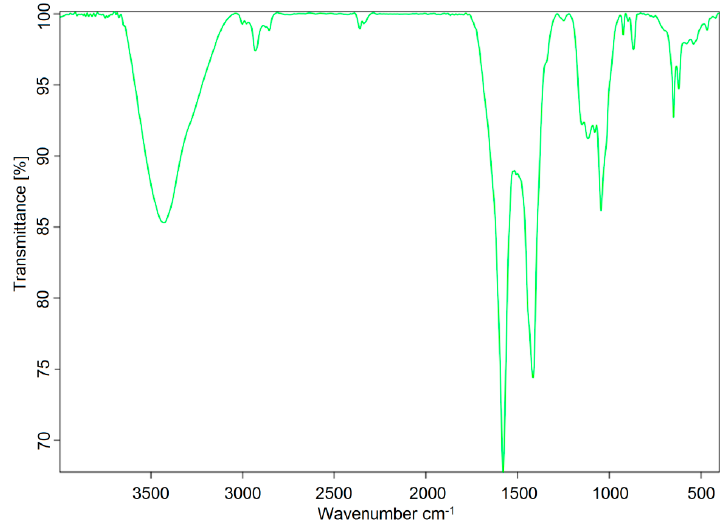
Figure 4. FT-IR spectrum of AX-I-3b.